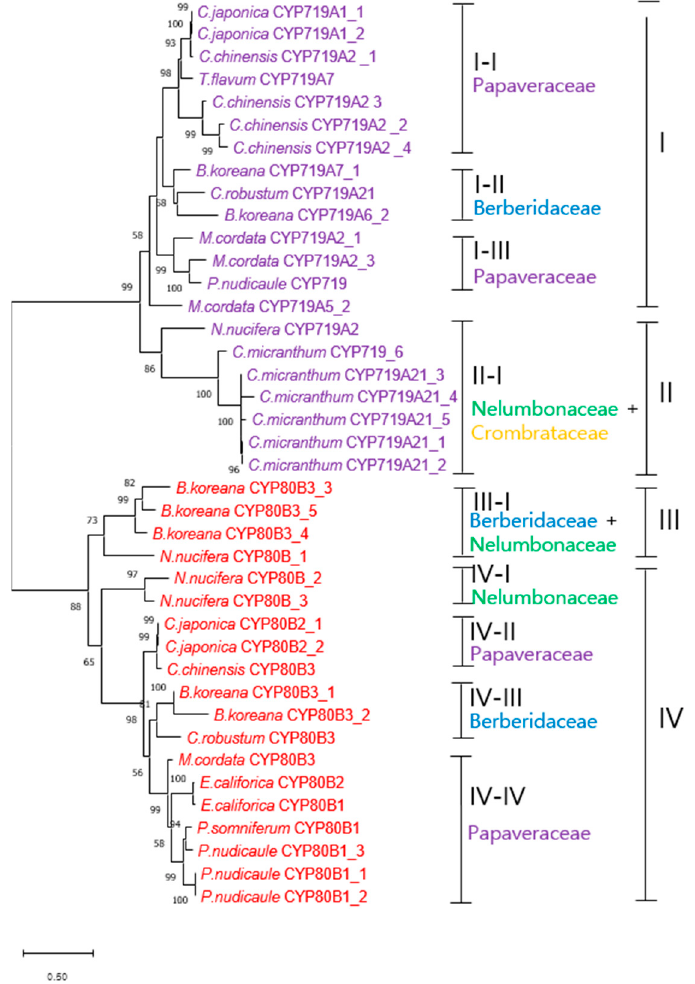
Figure 8. Phylogenetic tree of CYP80s and CYP719 from various plants. Species— B. lyceum : Berberis lyceum ; B. koreana : Berberis koreana ; C. chinensis : Coptis chinensis ; C. japonica : Coptis japonica ; C. robustum : Caulophyllum robustum ; E. californica : Eschscholzia californica ; M. cordata : Macleaya cordata ; N. nucifera : Nelumbo nucifera ; T. flavum : Thalictrum flavum ; P. somniferum : Papaver somniferum ; P. nudicaule : Papaver nudicaule ; C. micranthum : Combretum micranthum . The scale bar represents the phylogenetic distance derived from substitution per site in the sequence.